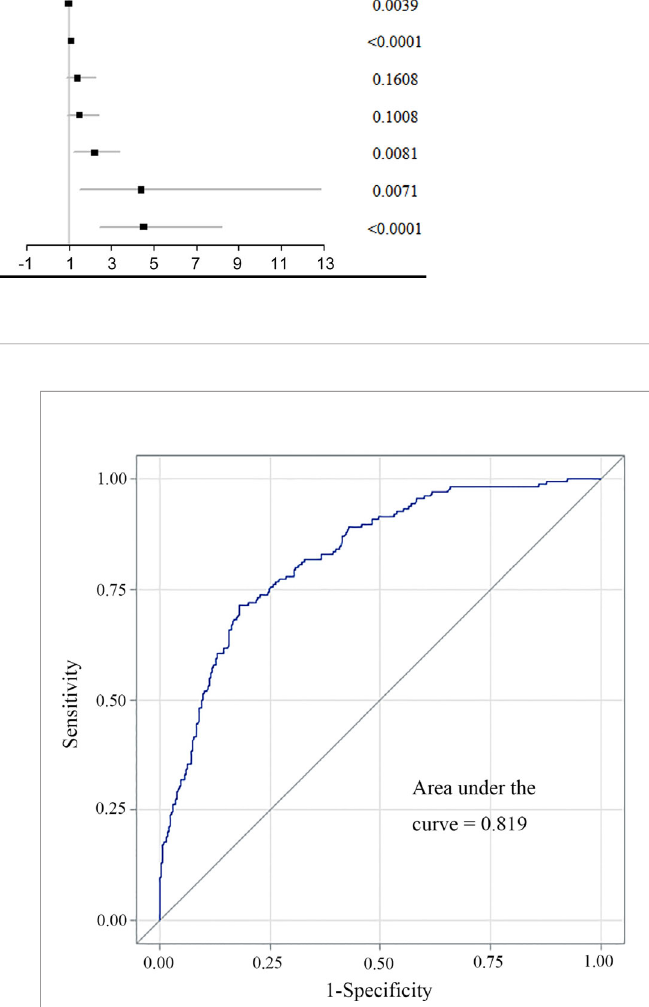
FIGURE 3 | The AUC of the ROC curve of the proposed methods for the diagnosis of DLN